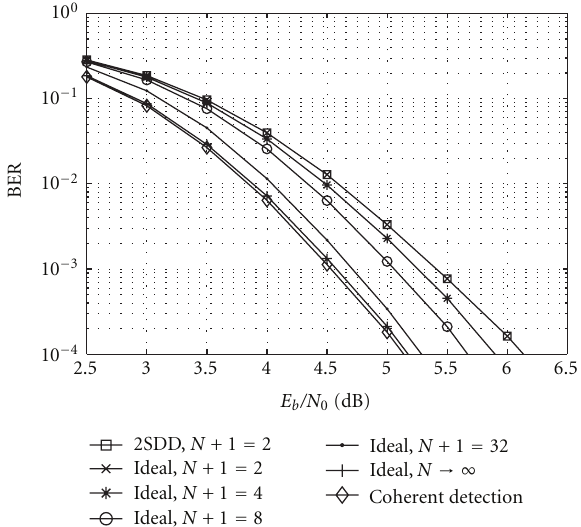
Figure 5: Bit-error performance for LLRs computed as in (25), that is, ideal LLRs, for di ff erent